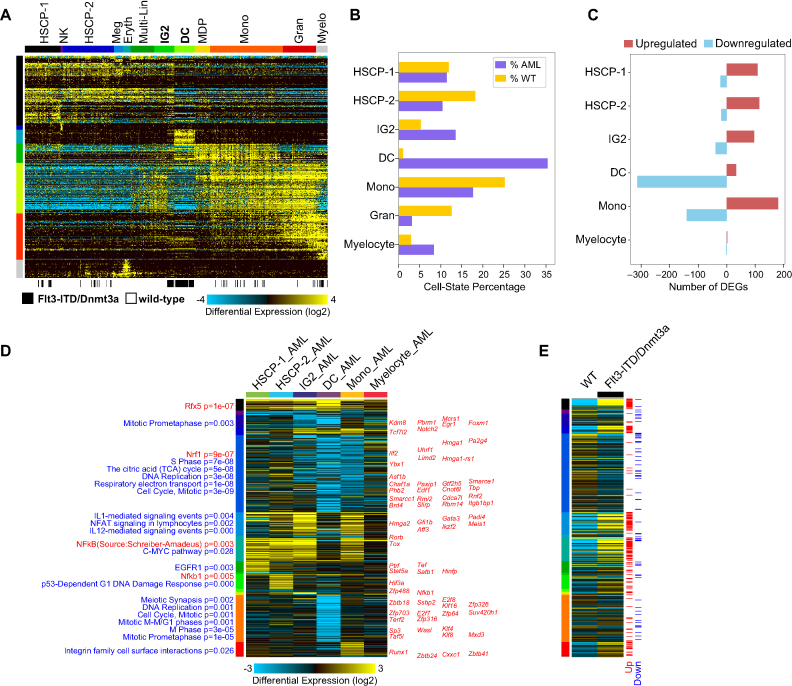
Cell population-specific impacts in transitioning progenitors and AML. (A) cellHarmony alignment of previously profiled splenic c-kit-positive AML cells relative to ICGS results from all captured normal mouse bone marrow hematopoietic progenitors (reference sample, Olsson et al. 2016). (B) AML cells were aligned most frequently to annotated dendritic cells (DC), monocyte progenitors (Mono), and previously described bipotential hematopoietic progenitors (IG2, Olsson et al. 2016). The AML DCs were high enriched relative to wild-type DCs by cellHarmony Fisher Exact test (P = 4.8E–24). C) Number of differentially expressed genes (DEG) by cell cluster (upregulated and down-regulated) for AML versus wild-type cell populations (fold > 2, P < 0.05, FDR adjusted). Negative numbers on the x-axis indicate downregulation (i.e. ‘-100’ means ‘100 downregulated genes’). (D) Heatmap of AML versus wild-type fold changes for all significant differentially regulated genes from panel C. Genes are grouped as global, regional, and local transcriptomic differences (DEG p-value ranked), with DEGs demonstrating global regulation shown at the top of the heatmap, co-regulated cluster impacts in the middle, and cell population-specific impacts at the bottom. The regional or co-regulated clusters indicate shared patterns of gene expression across multiple cell populations (e.g. HSCP-1 + HSCP-2 + IG2 + Mono). For each pattern, a separate up-regulated and down-regulated cluster is shown. Known transcription factors are displayed to the right of the heatmap where present by cellHarmony and enriched Pathway Commons gene-sets (blue) and transcription factor target sets (red) are displayed on the left next to each cluster in ranked order of significance (bottom to top). (E) Corresponding gene expression differences from bulk RNA-Seq of the AML model compared to wild-type bone marrow controls as an independent verification. Red lines = upregulated genes (fold >1.5, empirical Bayes moderated t-test P < 0.05 (FDR adjusted)), Blue lines = downregulated genes (fold < –1.5, empirical Bayes moderated t-test P < 0.05 (FDR adjusted)).